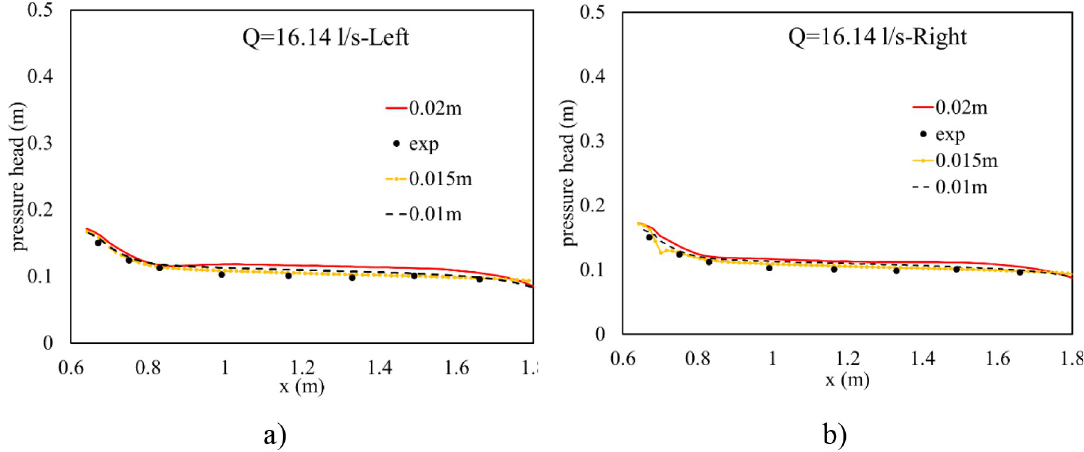
Fig 5. Pressure head distribution along the center line of two tubes of Run 3. a) Left box tube; b) Right box tube.